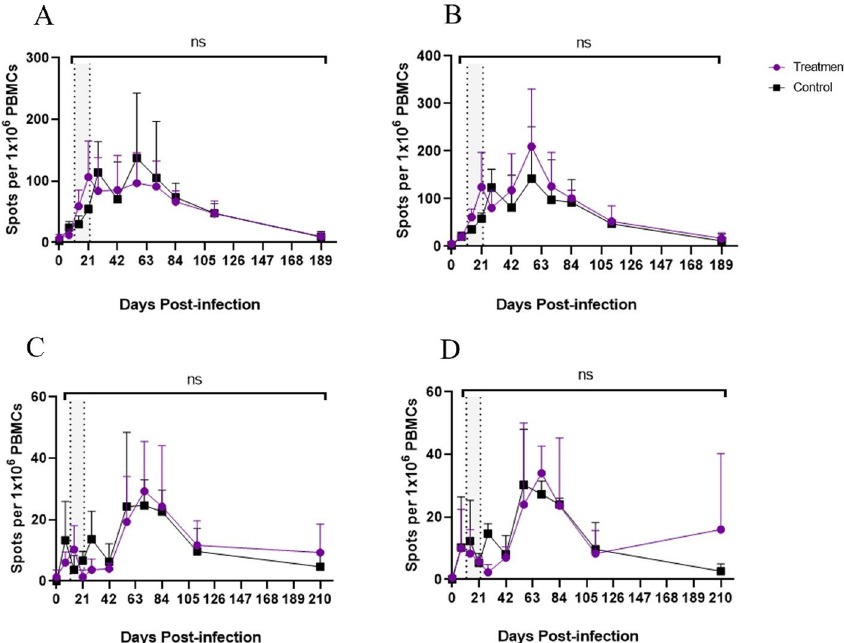
Figure 7. Cell-mediated immune response to MeV in macaques treated with remdesivir at onset of disease. Cells producing IFN-γ in response to: ( A ) pooled H glycoprotein peptides and ( B ) pooled N protein peptides. Cells producing IL-17 in response to: ( C ) pooled H glycoprotein peptides and ( D ) pooled N protein peptides as detected by ELISpot assay for late treatment group and control macaques. Shaded area indicates treatment